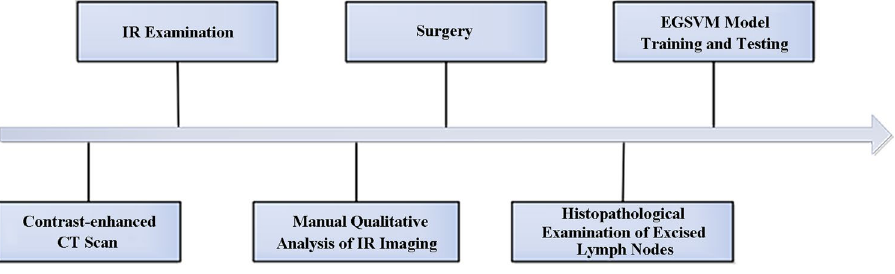
Figure 1. Timeline of the study